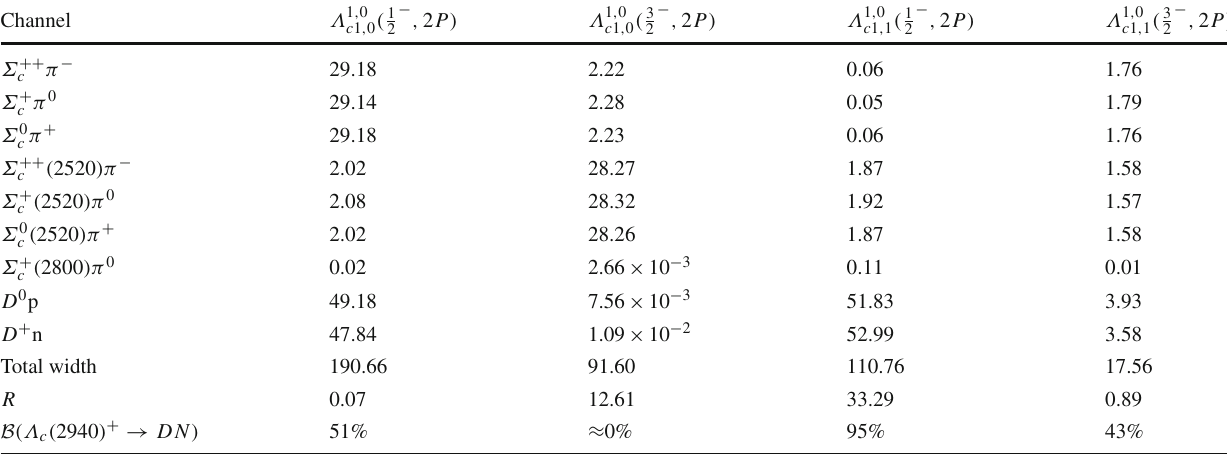
Table 6 Possible decay widths (MeV), branching fraction of DN channels and R = Γ(Σ c ( 2520 )π) Γ(Σ